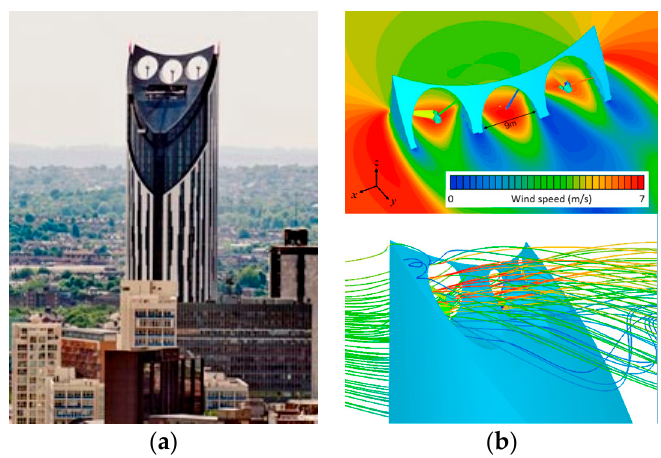
Figure 4. The Strata SE1 Apartment: ( a ) photo from the rear of the wind turbines; and ( b ) contour plot of wind speed on a horizontal cross-sectional plane ( top ) and streamlines passing through holes ( bottom ; CFD by the authors).